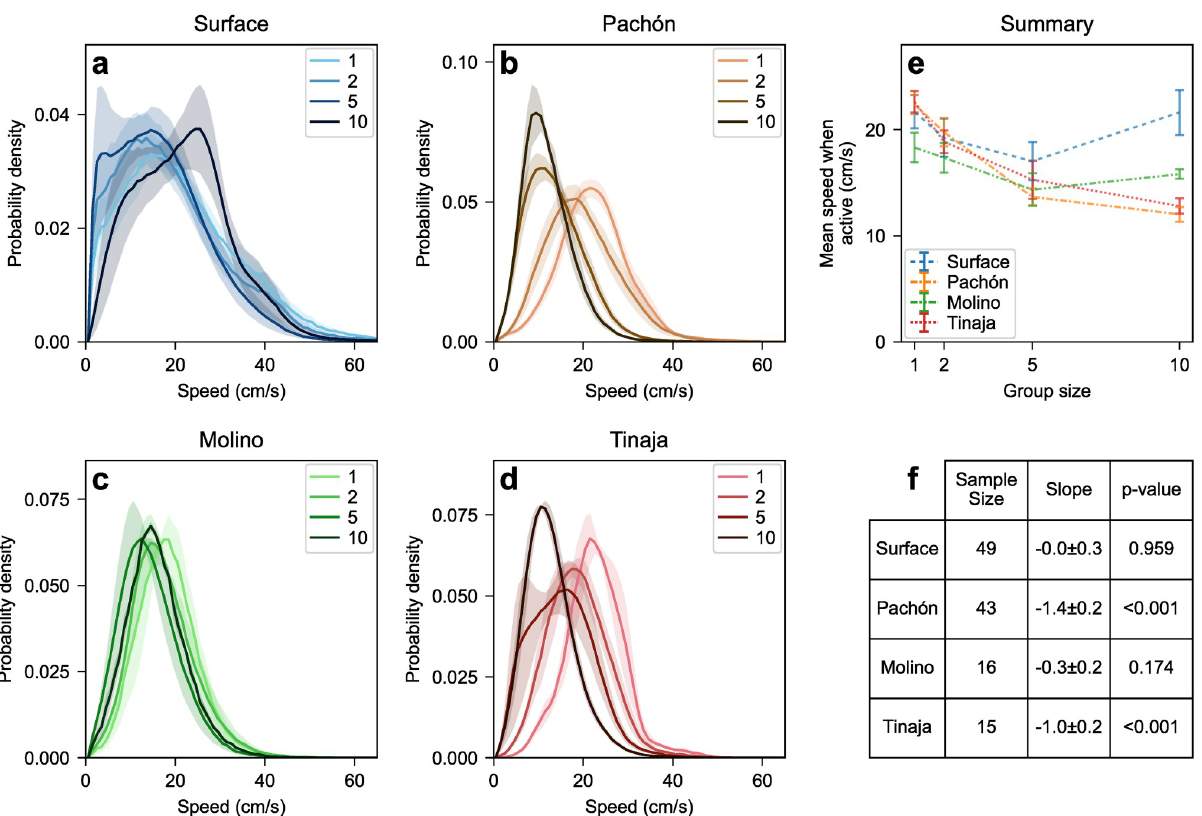
Fig 3. (abcd) Speed distribution as a function of group size for actively swimming (speed > 1 cm/s) surface fish and three cave populations (Pacho´n, Molino, Tinaja). The halo around each curve corresponds to one standard error on either side of the mean. (e) Mean speed as a function of group size for all types. Pacho´n and Tinaja populations slow down when group size increases whereas surface and Molino show no significant trend across 1 � n � 10. (f) Mean speed linear regression slopes: m Su = 0.0 ± 0.3 ( N = 49, p = 0.959), m Pa = − 1.4 ± 0.2 ( N = 43, p < 0.001), m Mo = 0.3 ± 0.2 ( N = 16, p = 0.174), m Ti = − 1.0 ± 0.2 ( N = 15, p <